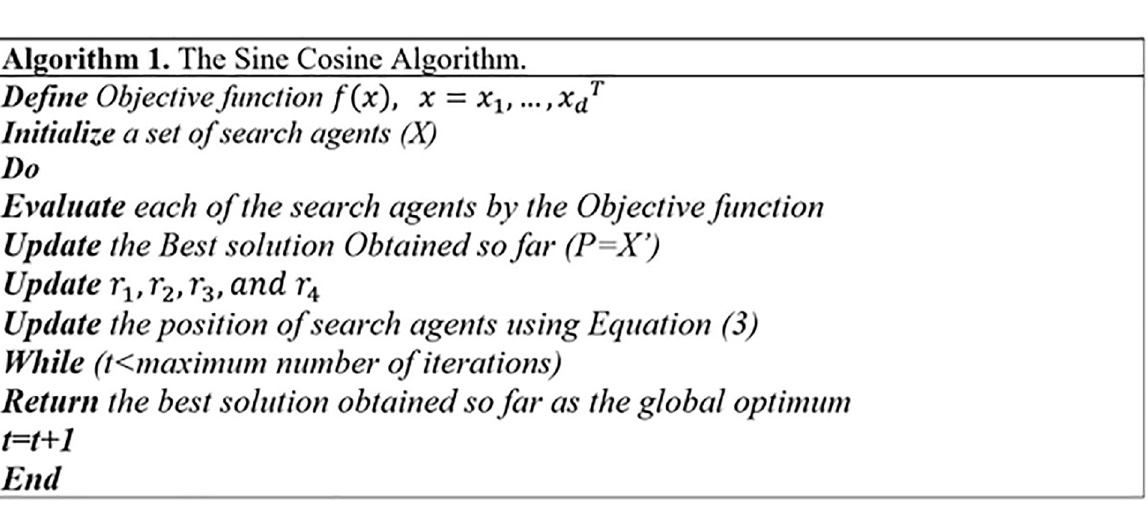
Fig 3. Algorithm